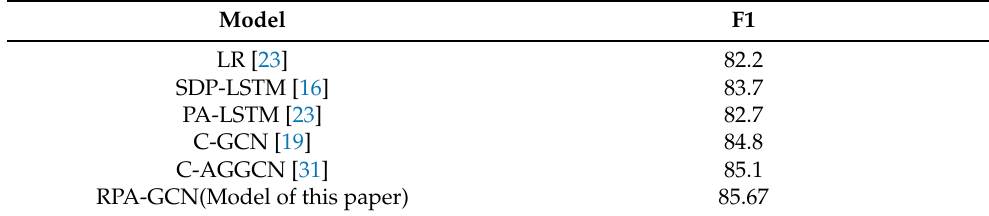
Table 1. SemEval2010 task 8 relational extraction of F1.